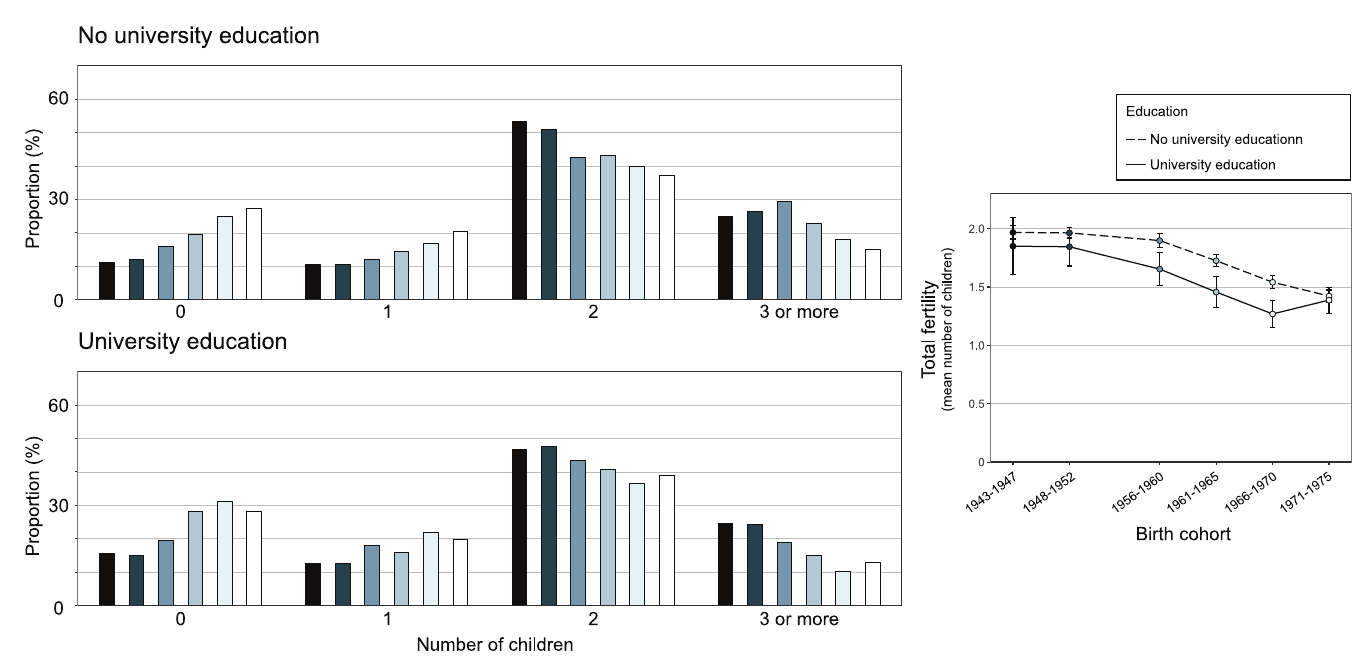
Fig 3. Trends in the distribution of number of children and total fertility across birth cohorts by education in women.